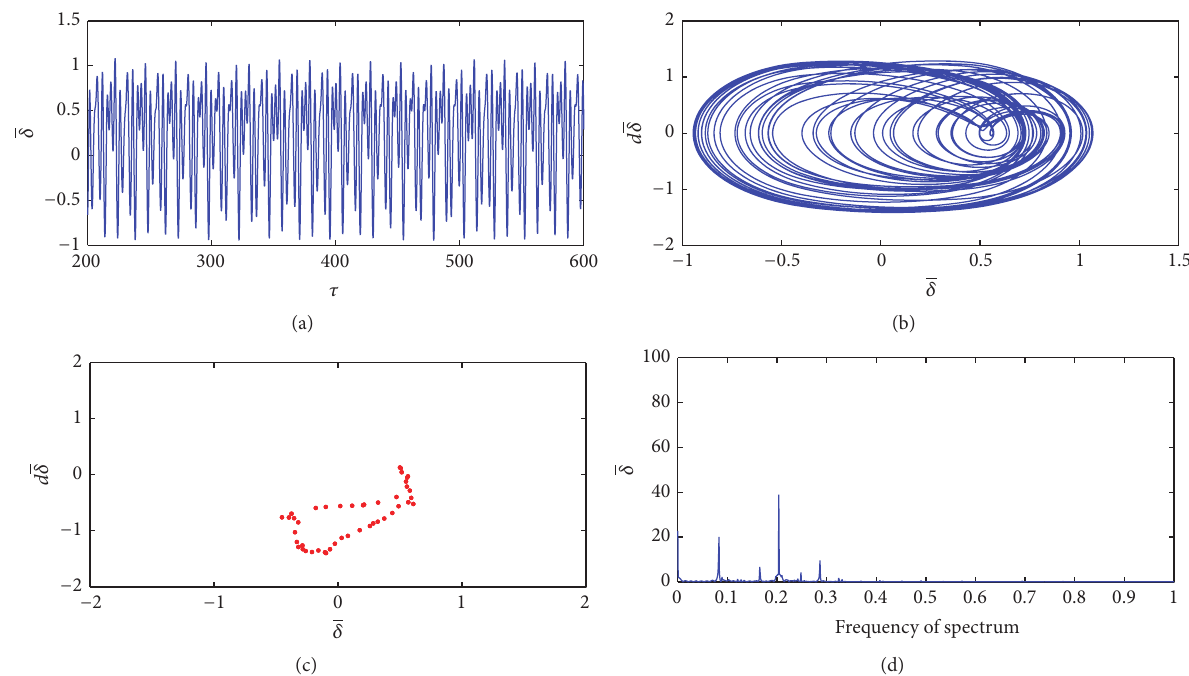
Figure 10: 𝜔 ℎ = 1.8 and 𝑓 = 1/3 : (a) time history; (b) phase plane; (c) Poincar´e map; (d) Fourier